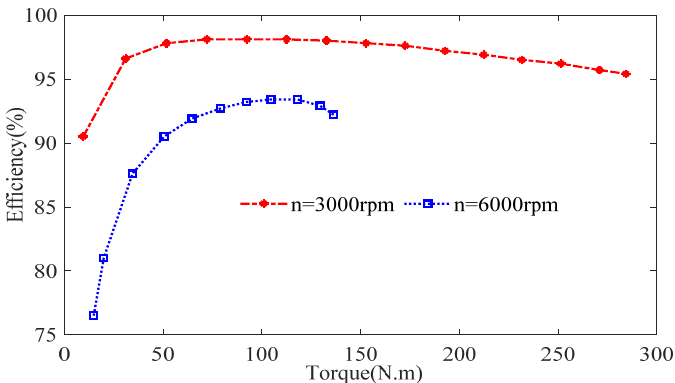
Figure 17. Measured efficiency versus torque at speed n = 3000 rpm and n = 6000 rpm.